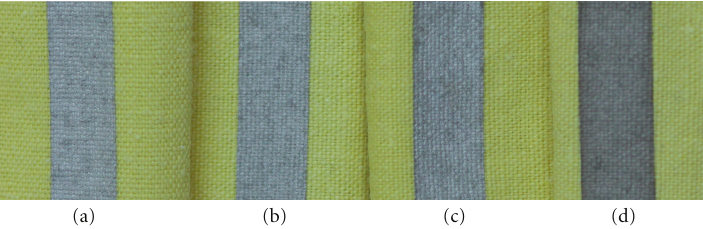
Figure 10: Photo of tags in di ff erent states. (a) 3 weeks after printing, (b) 11 weeks after printing, (c) washed once, and (d) washed ten times.